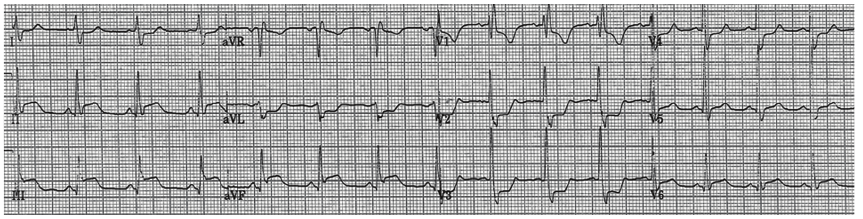
Figure 3: 12-lead ECG is depicting an ST-segment elevation in inferior leads and reciprocal changes in lead I, and morphology of right bundle branch block (rsR’) in lead V1 with ST-segment depressions in V1-V3 is observed after the adenosine injection.